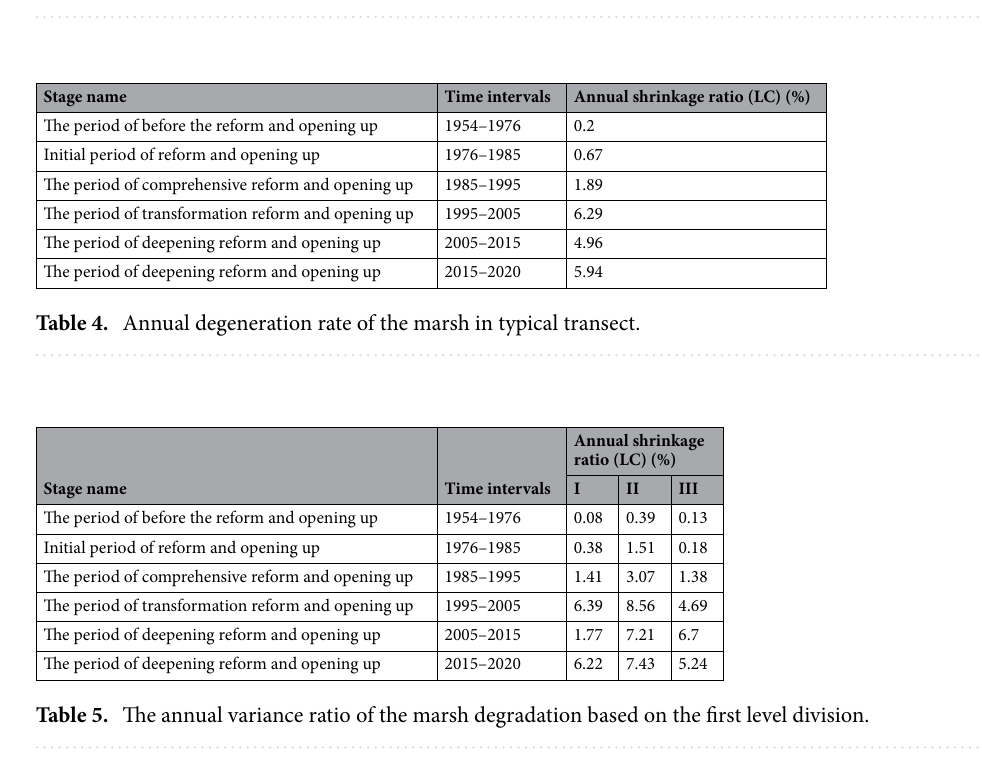
Figure 5. Marshes area the first-region in 1954–2020. Figure shows the area change of marshes in each of the first-region from 1954 to 2020. Which firstly occurred in I region and then expanded to other two regions.